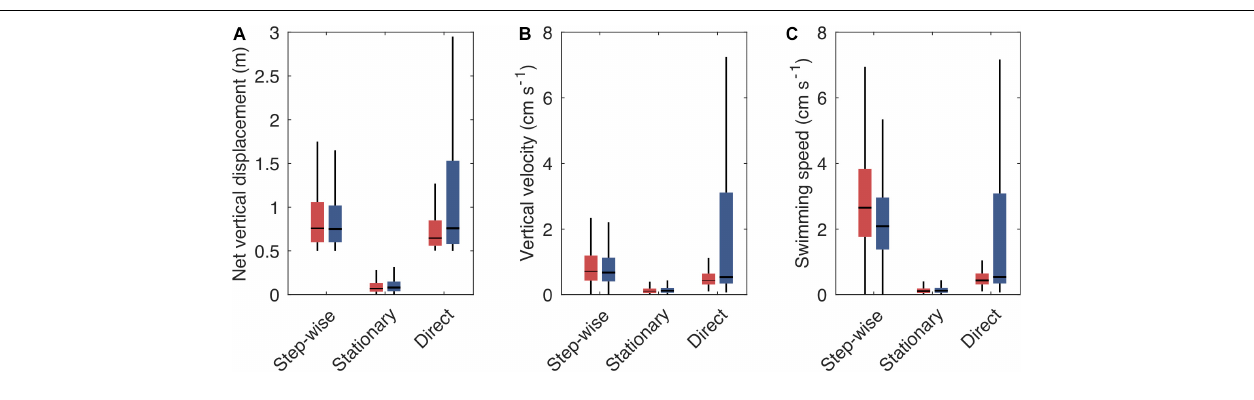
FIGURE 5 | Boxplot showing the vertical swimming characteristics [net vertical displacement (A) , vertical velocity (B) , and swimming speed (C) ] of step-wise, stationary and direct tracks when ascending (red boxes) or descending (blue boxes). Vertical velocity is the net vertical displacement over time, including pauses, while swimming speed is the average velocity during active phases. Boxes indicate the interquartile range, horizontal lines the median, vertical lines the first and fourth quartile. Outliers are not shown. For number of tracks with the respective swimming pattern see Table 2